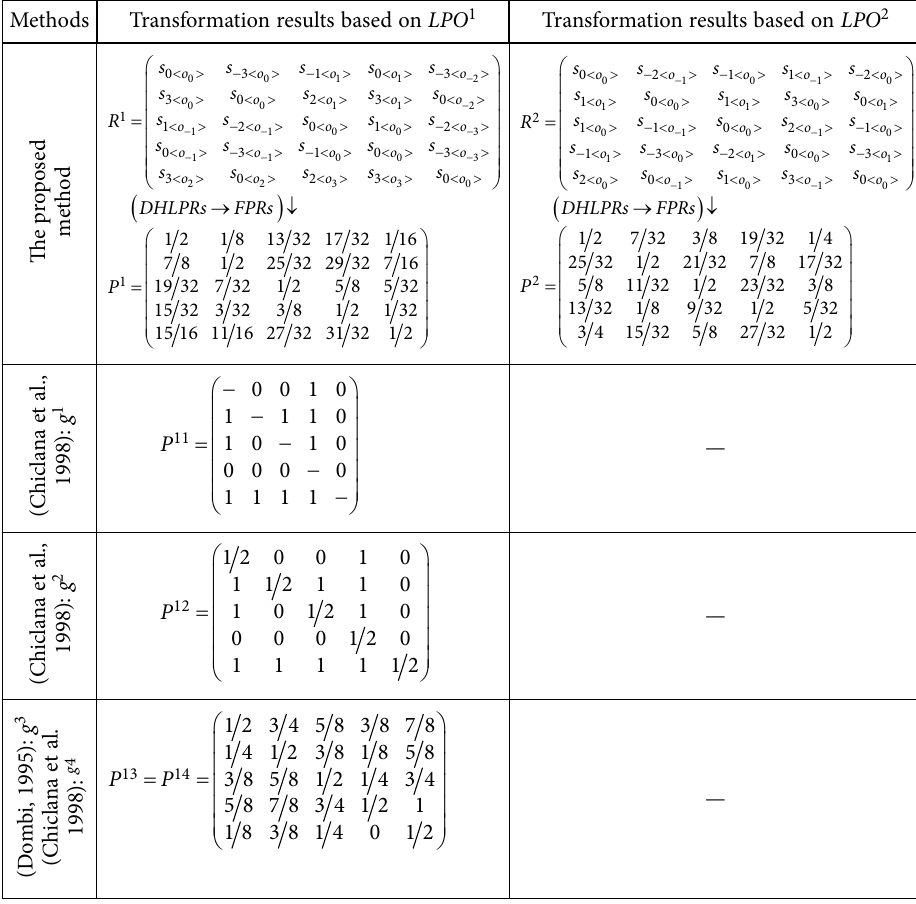
Table 2. The transformation results based on different methods Methods Transformation results based on LPO 1 Transformation results based on LPO